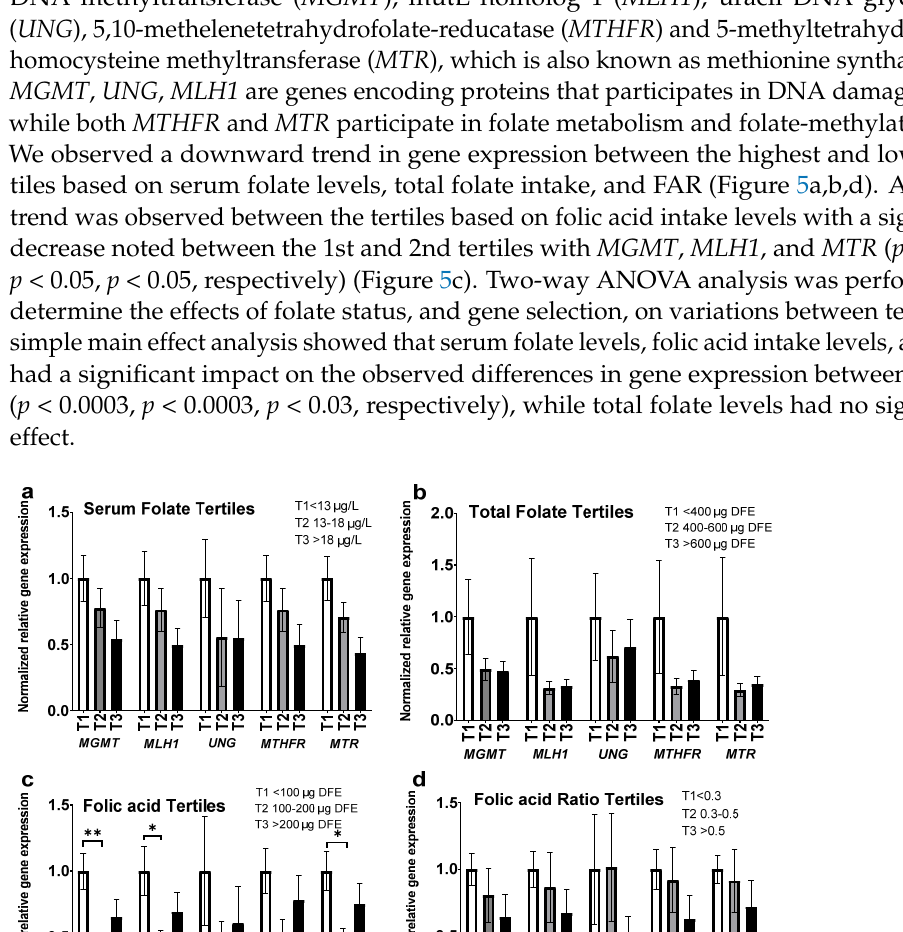
Figure 4. Global LINE-1 methylation levels in human lymphocytes based on: ( a ) serum folate tertiles 1. ( b ) Total dietary folate intake tertiles. ( c ) Dietary folic acid intake tertiles. ( d ) dietary folic acid intake: total folate intake ratio tertiles. Serum folate presented as µg/L (ng/mL), DFE; (dietary folate equivalent), data presented as mean (±SEM), n = 33.